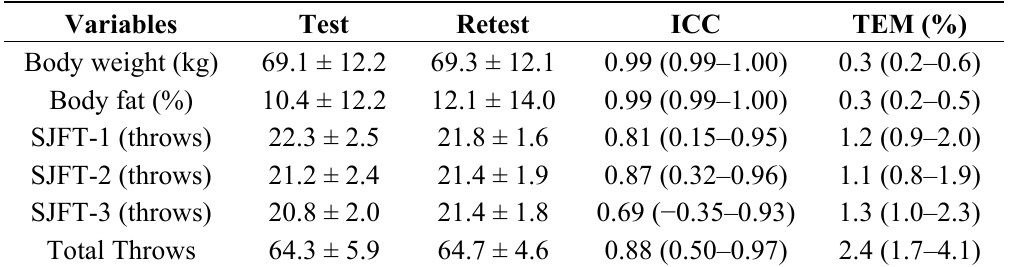
Table 1. Mean ± SD, intraclass correlation coefficient (ICC), and typical error of measurement (TEM) for anthropometric measurements and special judo fitness test outcome (throws) during test and retest